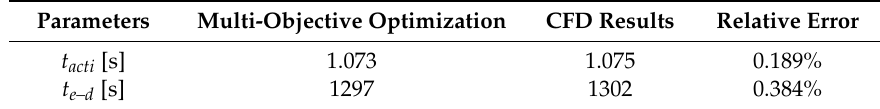
Table 4. Comparison of the results between simulation and multi-objective optimization when ∆ d a = 0, ∆ d = 0.161 b